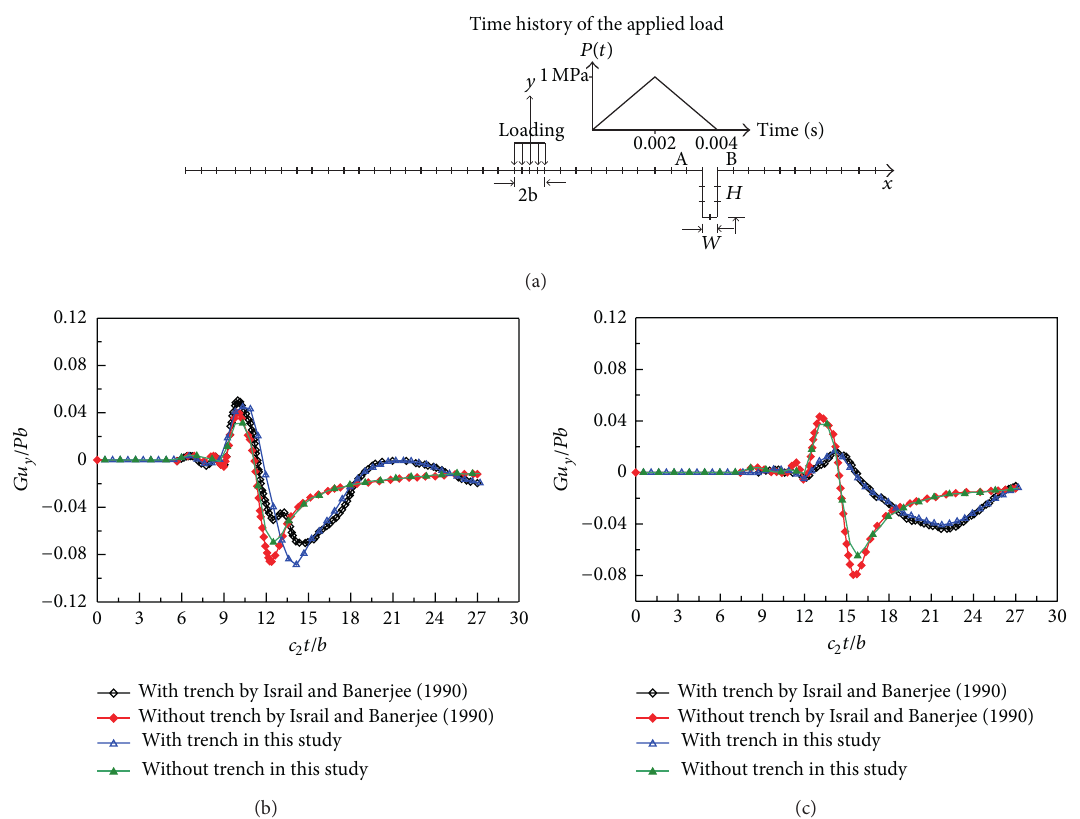
Figure 1: Effect of open trench on transient vibration: (a) boundary elements mesh and the applied loads were used by Israil and Banerjee [17], (b) displacement time history at Point A (before open trench), and (c) displacement time history at Point B (after open trench).